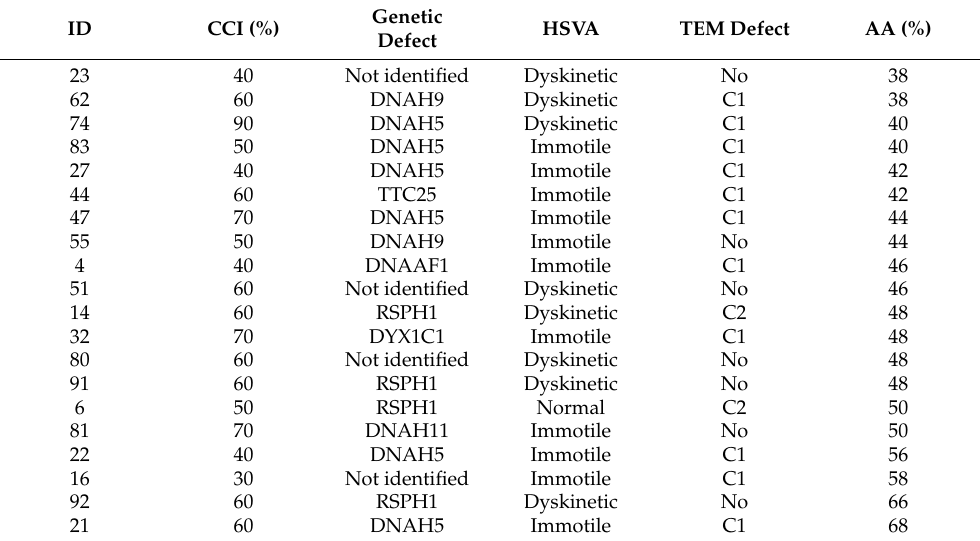
Table 2. Summary of diagnostic tests and CCI of PCD patients according to axonemal asymmetry.